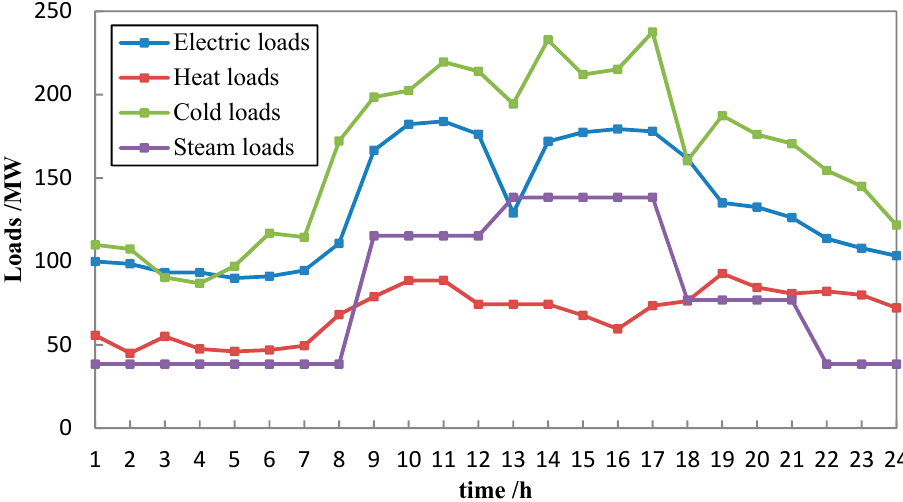
Figure 4. Typical daily electricity, steam, cold, and heat load curves.